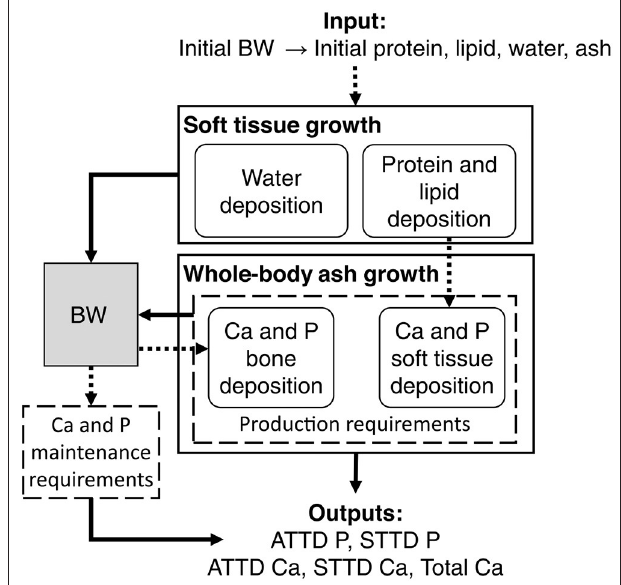
FIGURE 3 | General layout of the proposed mechanistic model predicting total calcium (Ca) and apparent and standardized digestible phosphorus (ATTD and STTD P) requirements of growing pigs (